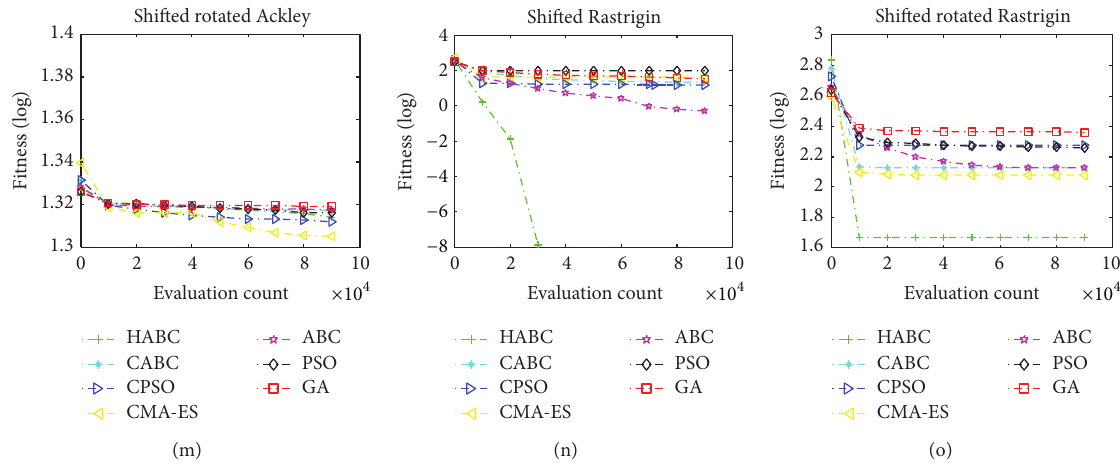
Figure 6: The median convergence results of 100D continuous functions. (a) Sphere function. (b) Rosenbrock function. (c) Quadratic function. (d) Sin problem function. (e) Rastrigin function. (f) Schwefel function. (g) Ackley function. (h) Griewank function. (i) Shifted sphere function. (j) Shifted Schwefel function. (k) Shifted Rosenbrock function. (l) Shifted rotated Griewank function. (m) Shifted rotated Ackley function. (n) Shifted Rastrigin function. (o) Shifted rotated Rastrigin